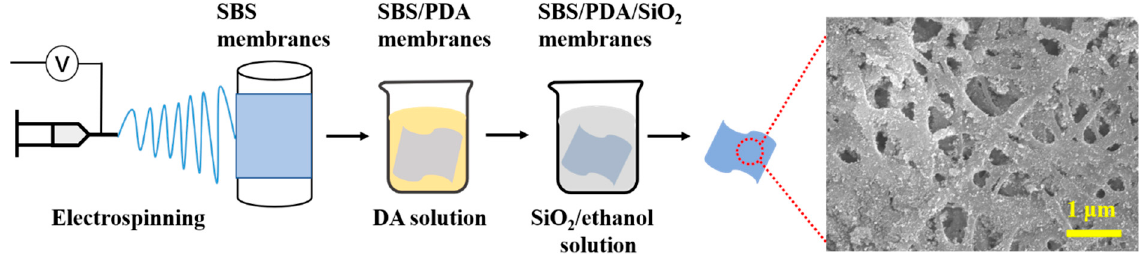
Figure 1. Schematic drawing showing the preparation of the SBS/PDA/SiO 2 nanofibrous membrane and an SEM image of the prepared membrane. and an SEM image of the prepared